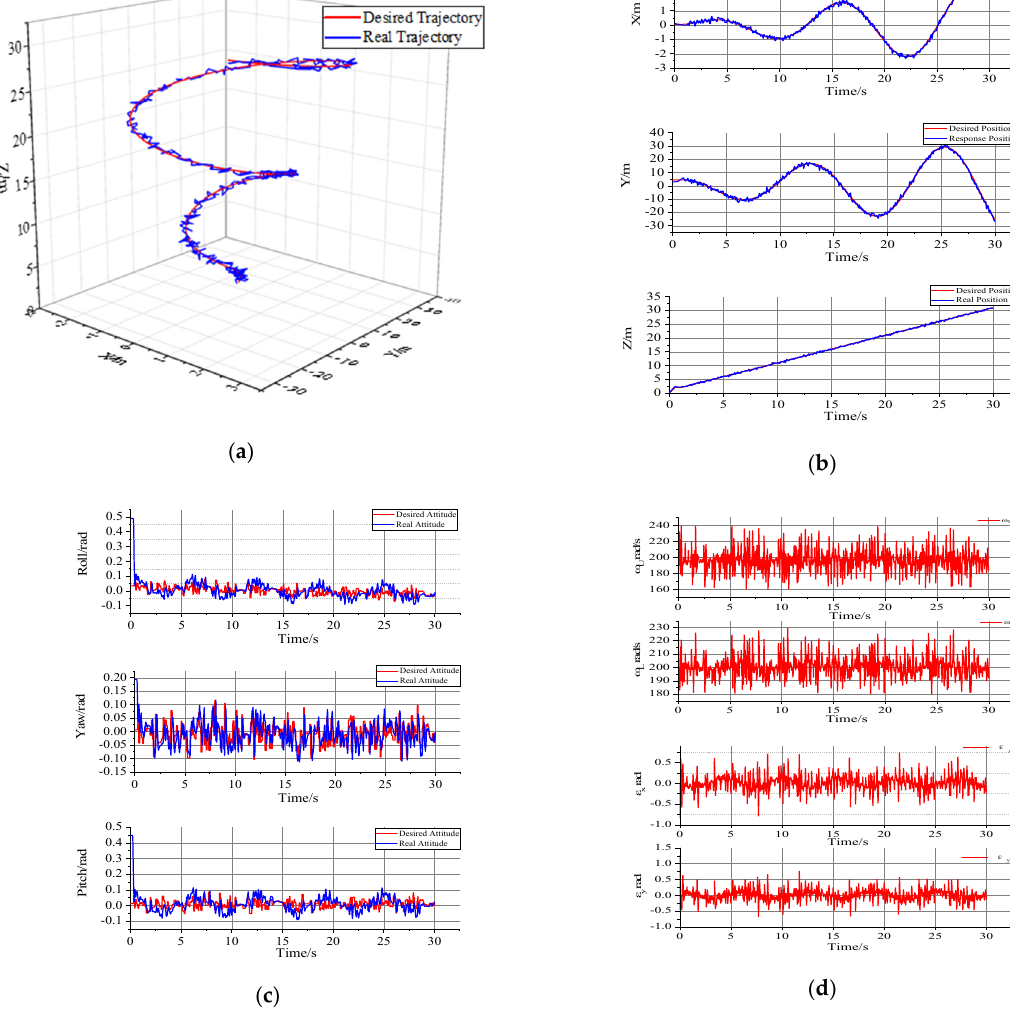
Figure 5. Analysis chart with disturbance. ( a ) Three-dimensional trajectory tracking; ( b ) expected and actual position responses; ( c ) expected and actual attitude response diagrams; ( d ) virtual control input.